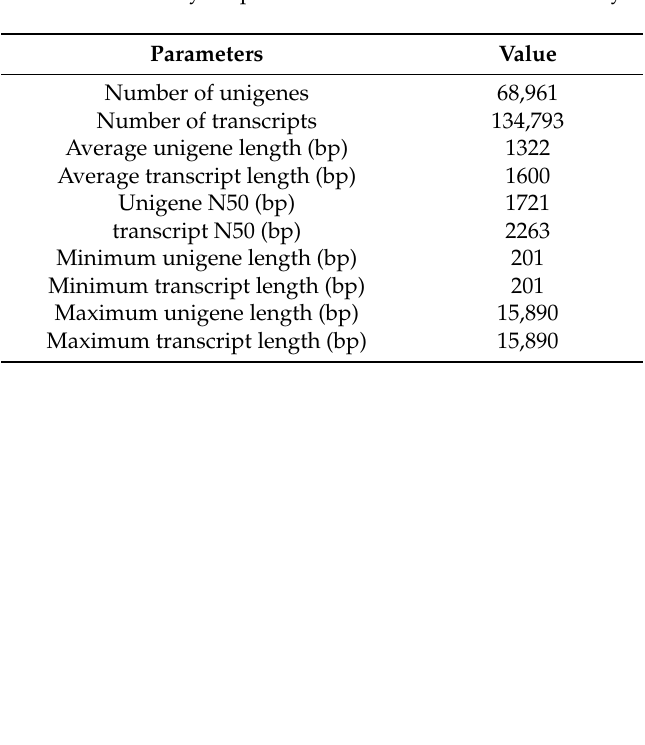
Table 2. Assembly output statistics of all clean data in